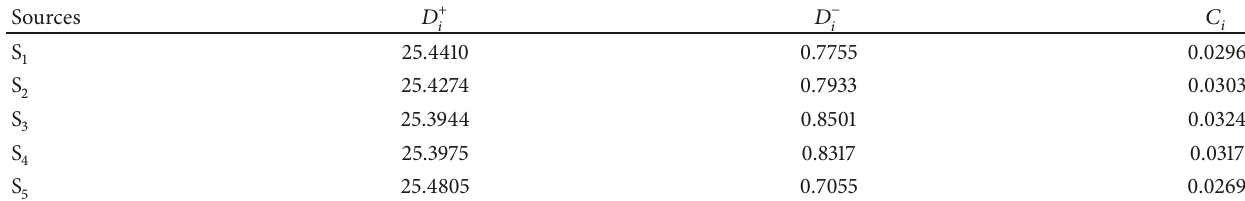
Table 19: Fuzzy TOPSIS outputs for the mini-grid energy sources problem.